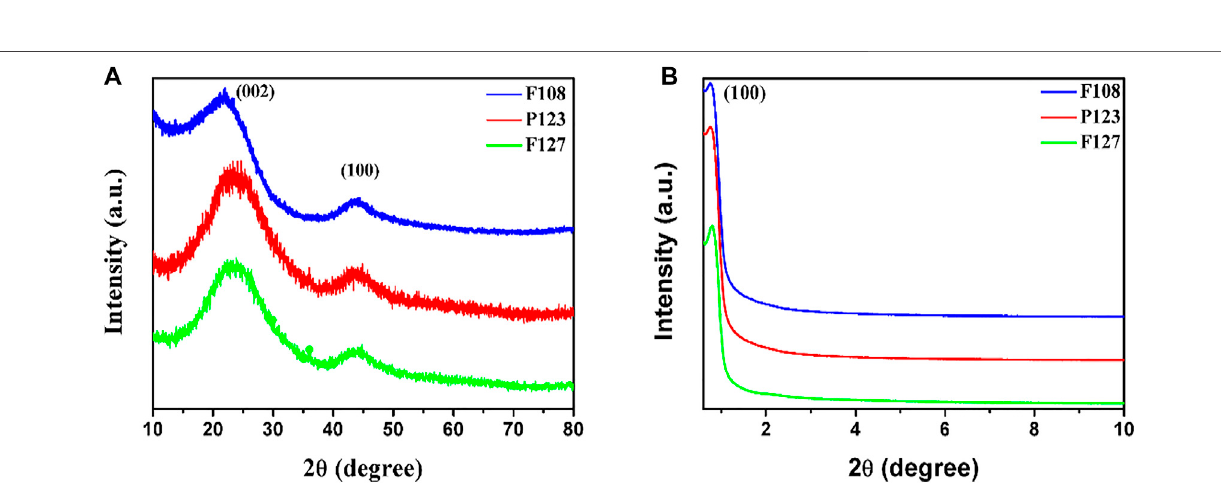
Frontiers in Chemistry |